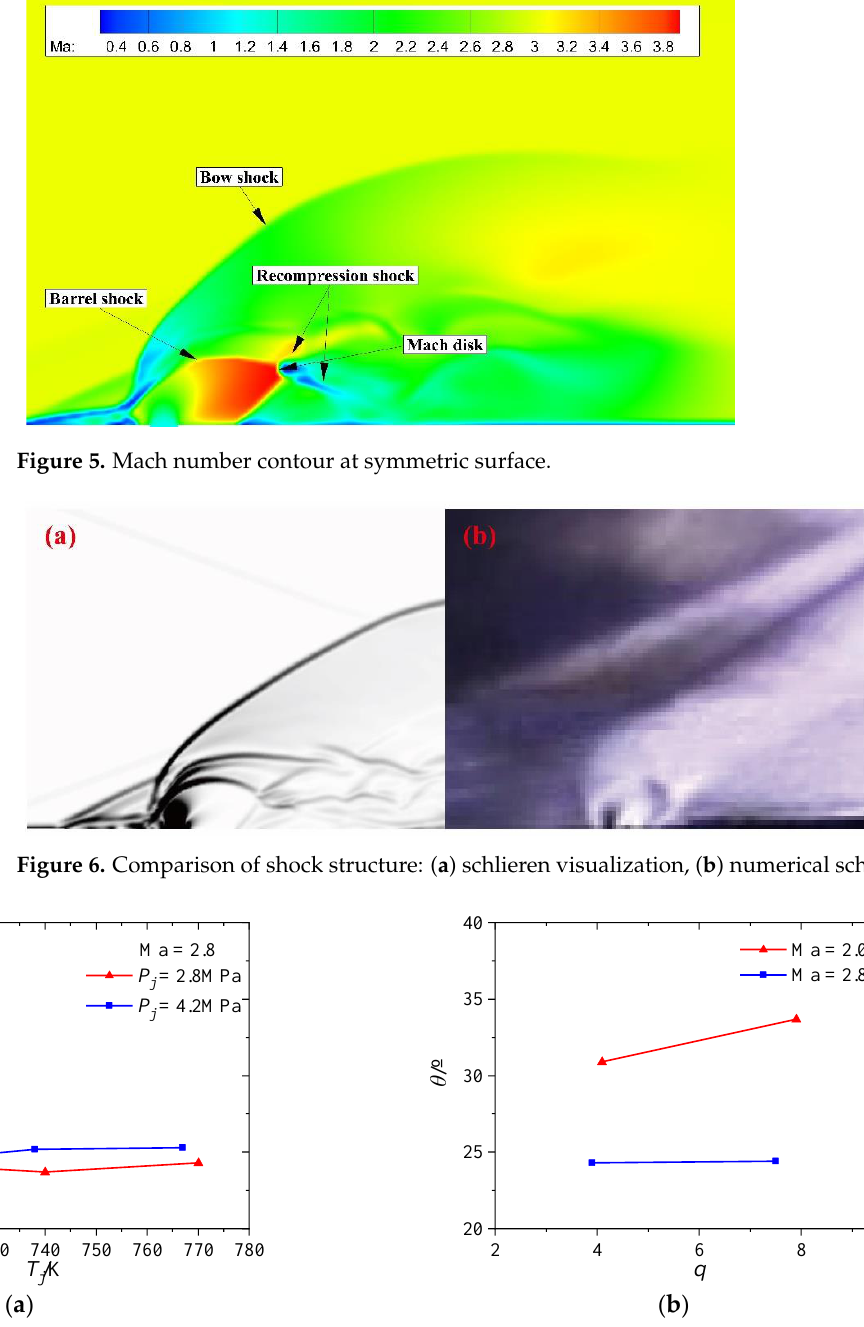
Figure 7. Bow shock angle under different test conditions. ( a ) Injection condition. ( b ) Mach number for incoming flow.